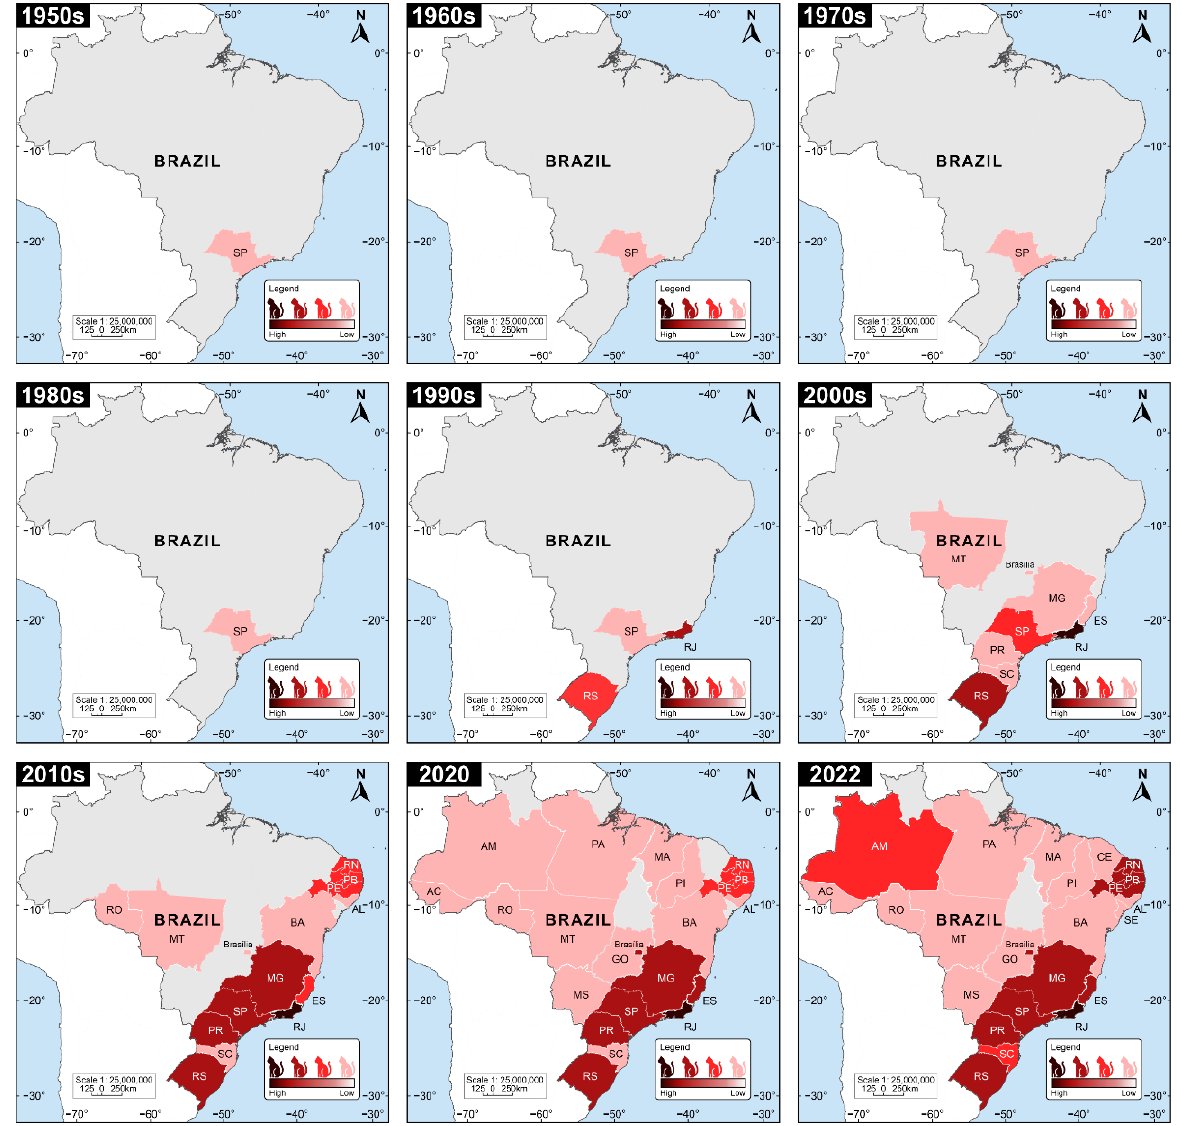
Figure 2. Temporal evolution of feline sporotrichosis cases in Brazil between 1950 and 2022. The current scenario of sporotrichosis shows signs of frank expansion. The map was drawn based on case reports available on the literature [5,10,12,15,31,32,68,91,98–101,105,108,114–153].